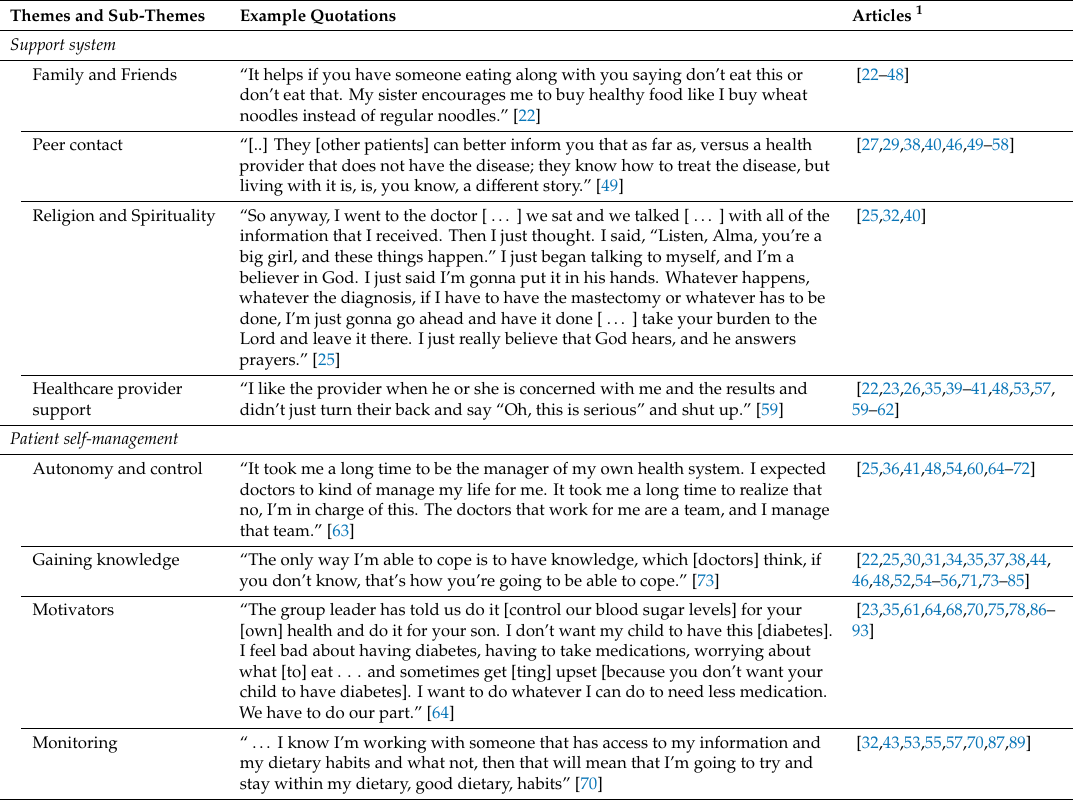
Table 3. Summary of main results and